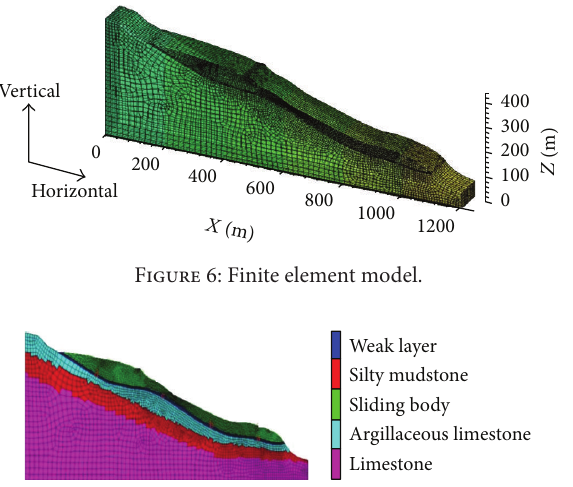
Figure 7: Distribution of rock